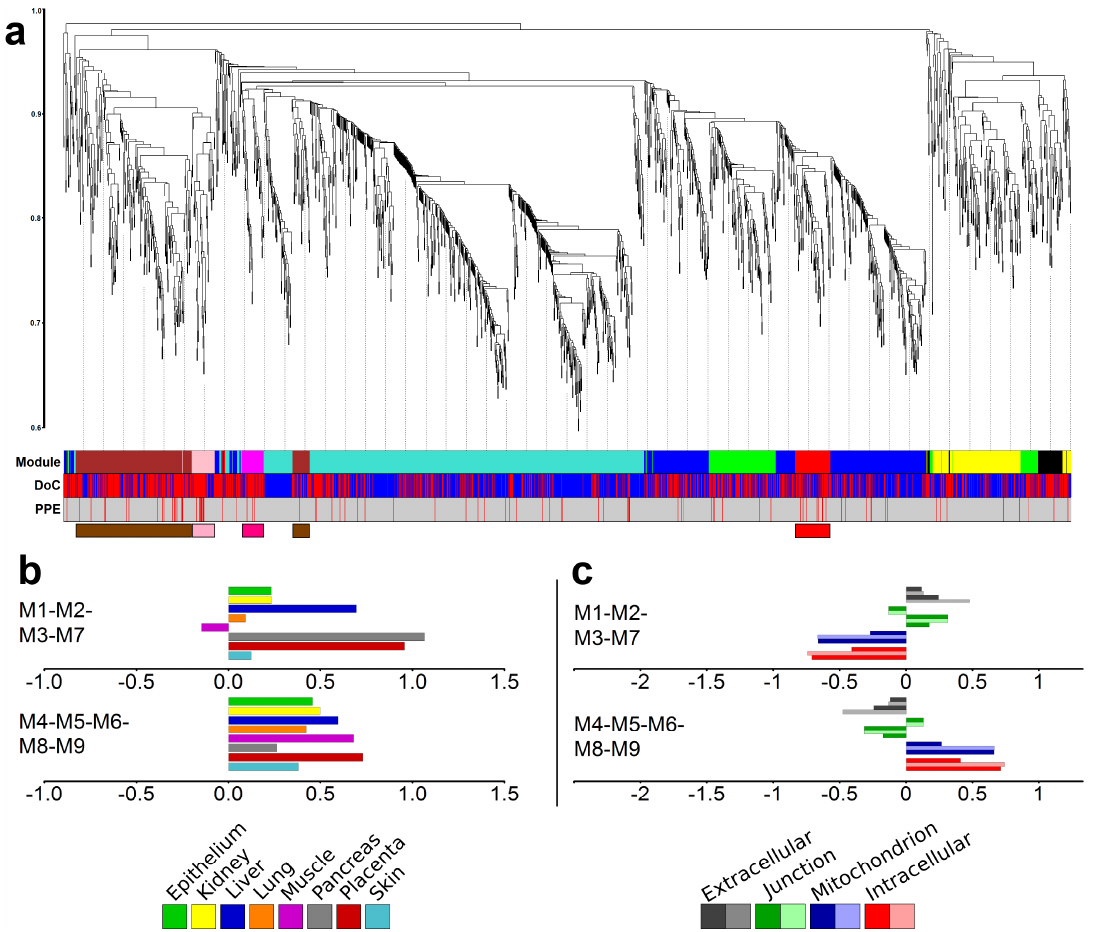
Figure 4. Modules of co-expressing genes. ( a ) Weighted co-expression network analysis (WGCNA) of differentially expressed (DE) genes identified five major and four minor modules. The y-axis represents the distance metric (1-TOM); the three levels of colored bars below the chart indicate the identified modules, the direction of change of expression (DoC; red: up-regulated, blue: down-regulated), and predominantly placental expressed (PPE) genes. The four modules enriched in PPE genes are depicted in the bottom with module-colored boxes. ( b ) Tissue enrichments of the combination of placental (M1-M2-M3-M7) and non-placental (M4-M5-M6-M8-M9) modules as analyzed with the DAVID bioinformatics tool. ( c ) Cellular component enrichments for the same two module groups as analyzed by DAVID.